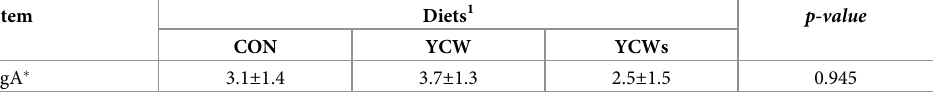
Table 7. Immunoglobulin A concentration (mg/g of dry matter) on the feces of dogs fed diets with the addition of different yeast cell wall preparations (mean and standard error of the mean). Item